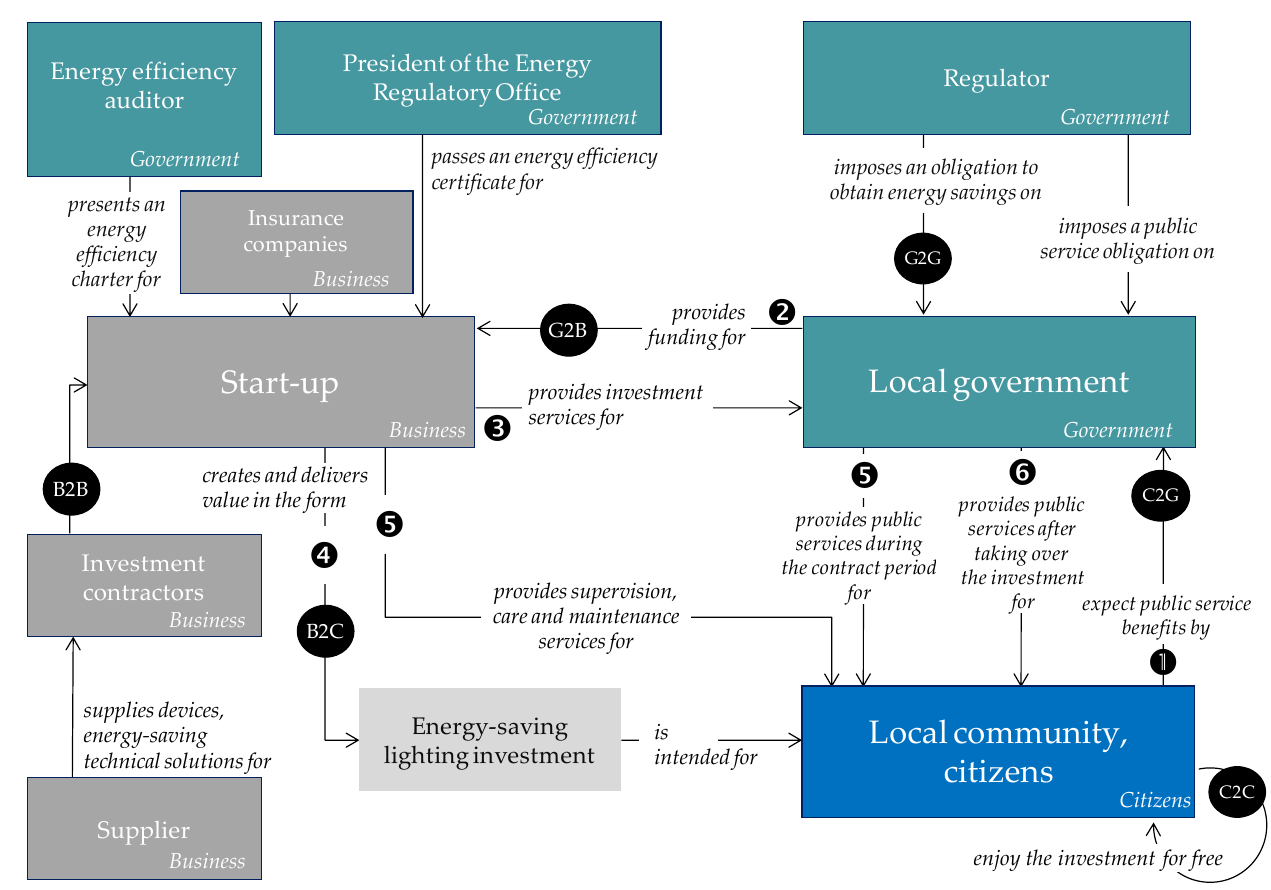
Figure 2. Relations between the market parties in the ecosystem in the life cycle of the investment service. Source: author’s own development.